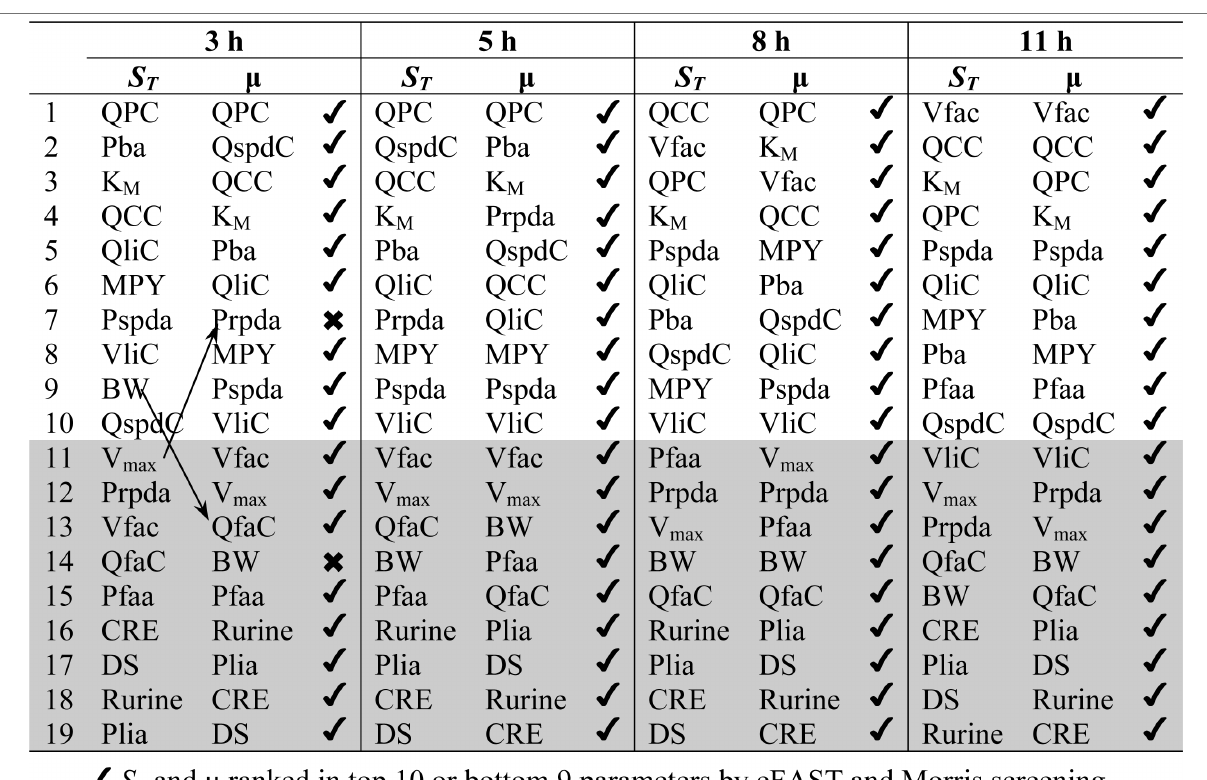
Table 3 | Comparison of ranking of model parameters for variance in